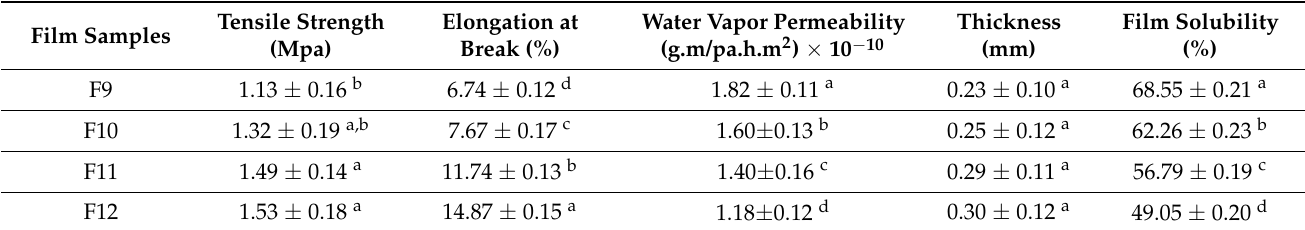
Table 1. Tensile strength, elongation at break, water vapor permeability, thickness, and film solubility of films prepared using FPC at different